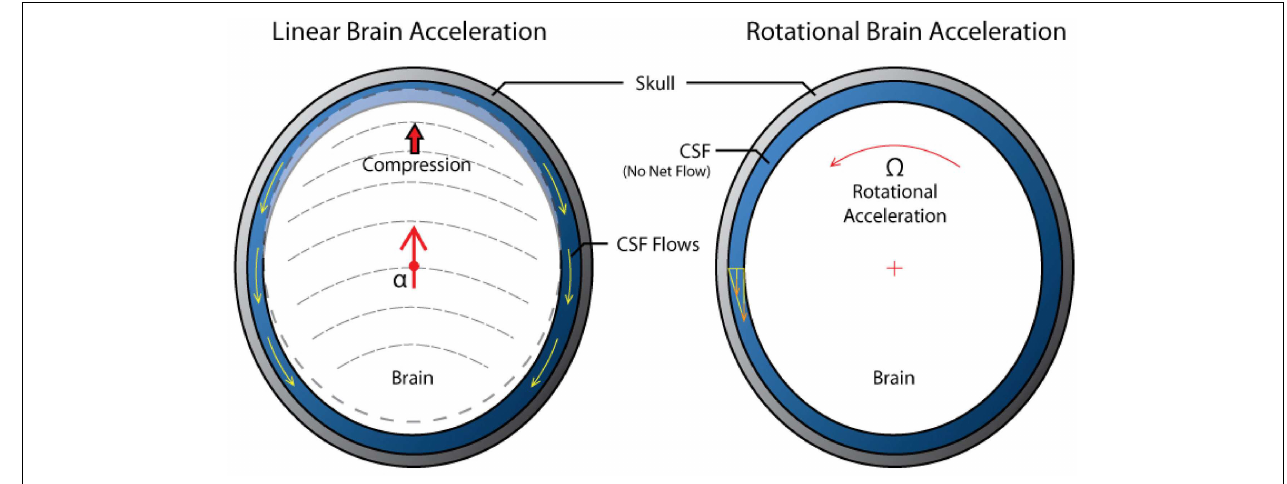
FIGURE 4 | Schematic of brain-CSF interaction in linear and rotational acceleration